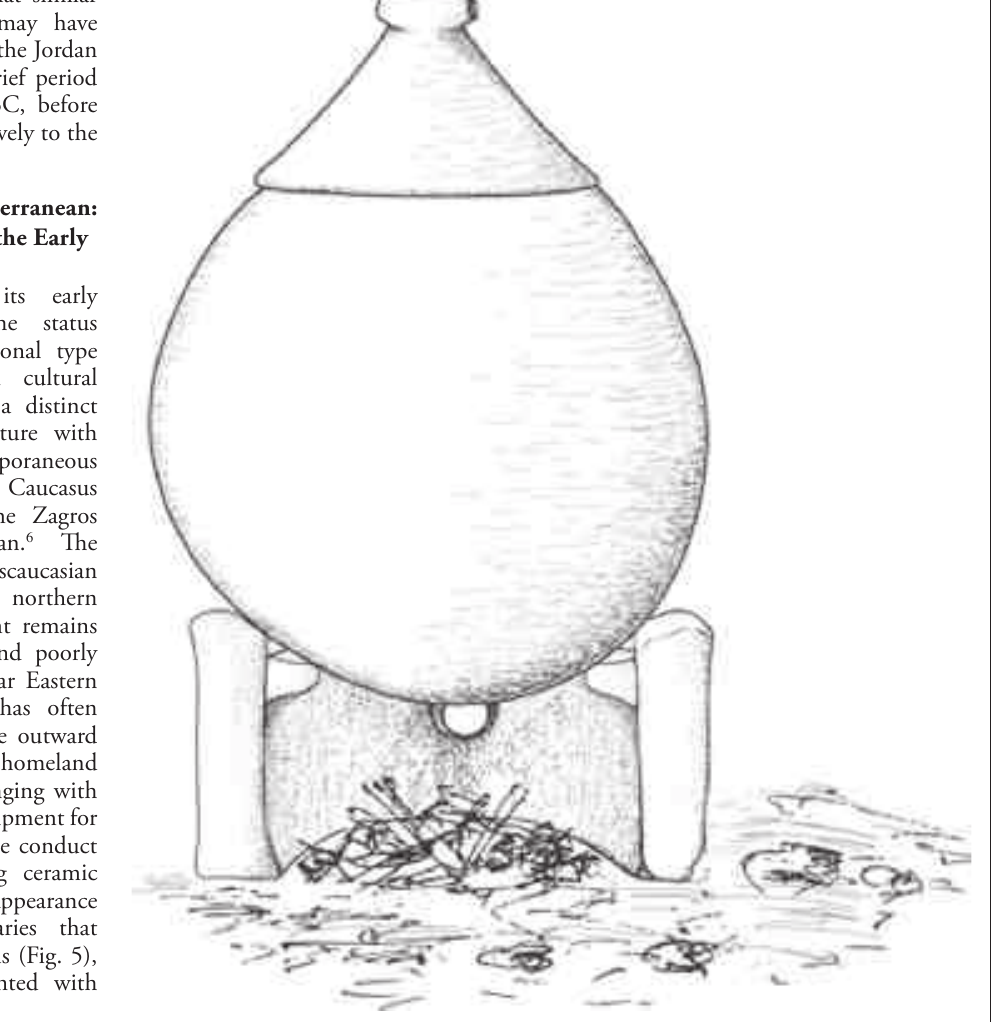
Figure 5 Reconstruction of “Transcaucasian” cooking practices, on a portable hearth boundary (or